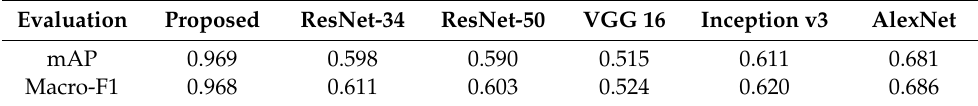
Table 4. The test results of the proposed MCC-CycleGAN and other networks.